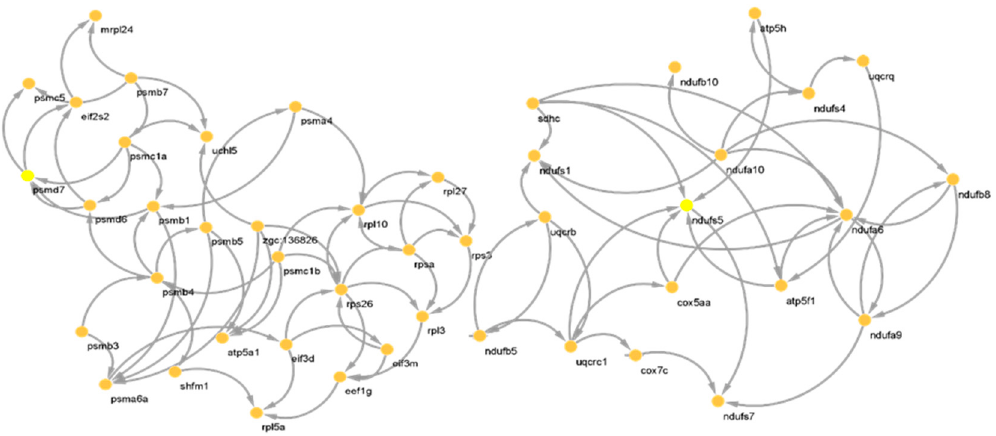
Figure 4. Reconstructed Bayesian network (causative relationship among genes) of genes within Module 1 (right) and Module 2 (left) of the PPI network.